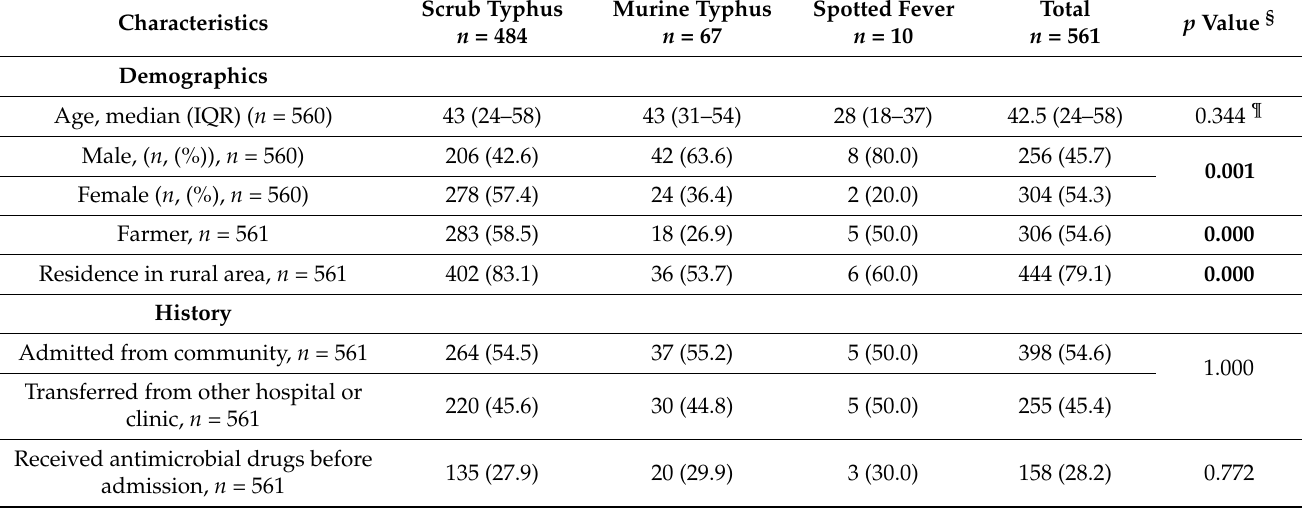
Table 2. Demographics, history, clinical manifestations, laboratory results, treatment, and outcomes of 484 scrub typhus, 67 murine typhus and 10 spotted fever